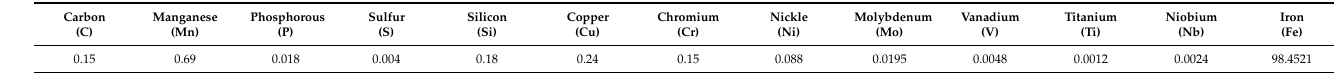
Figure 2. The FE model of the butt joint. Table 1. The chemical composition of ASTM A36.